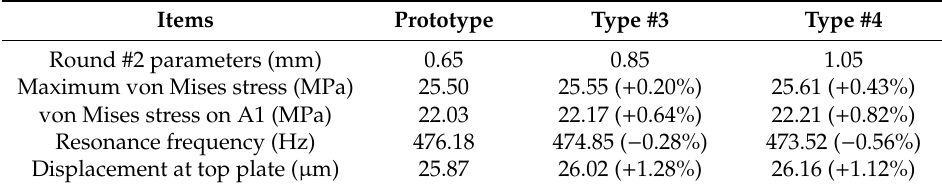
Figure 19. von Mises stress distribution on spring with different round #2 parameters. Table 4. Analysis result comparison between different round #2 parameters. Table 4. Analysis result comparison between di ff erent round #2 parameters.